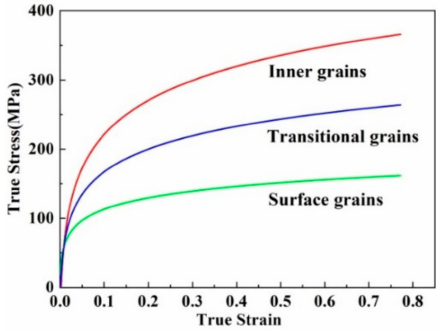
Figure 9. Flow stress of three kinds of grains at an average grain size of 30 µ